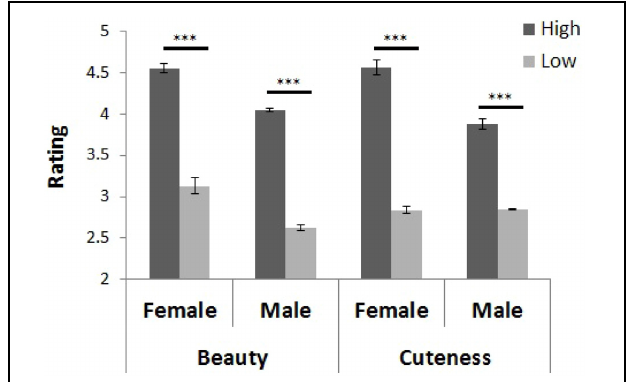
FIGURE 1 | Stimulus grouping. The deep gray shows high rated groups, and the light gray shows low rated groups. The error bars show the SEM across participants. ∗∗∗ p <